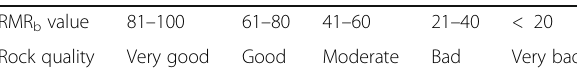
Table 6 Rock Mass Rating basic (RMR b ) (Bieniawski